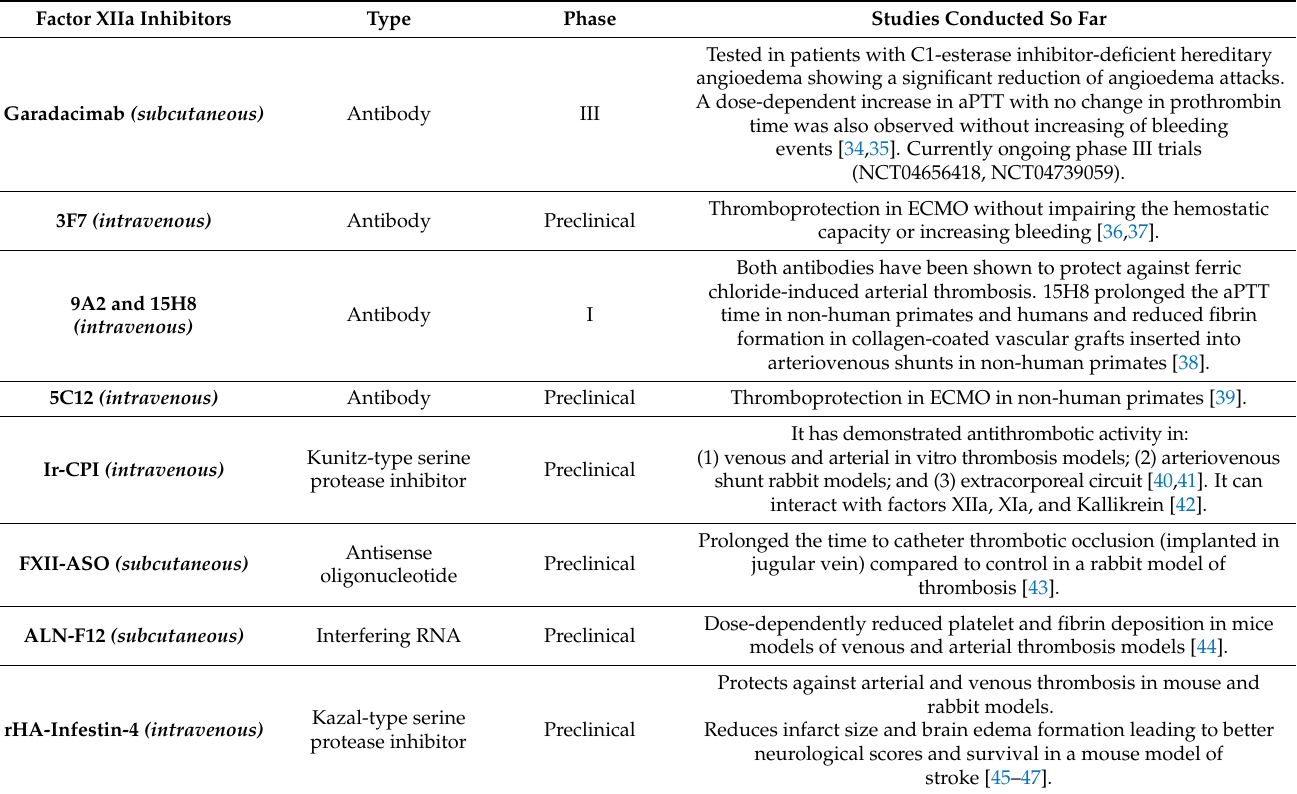
inhibitors and details the studies conducted so far to assess their efficacy and